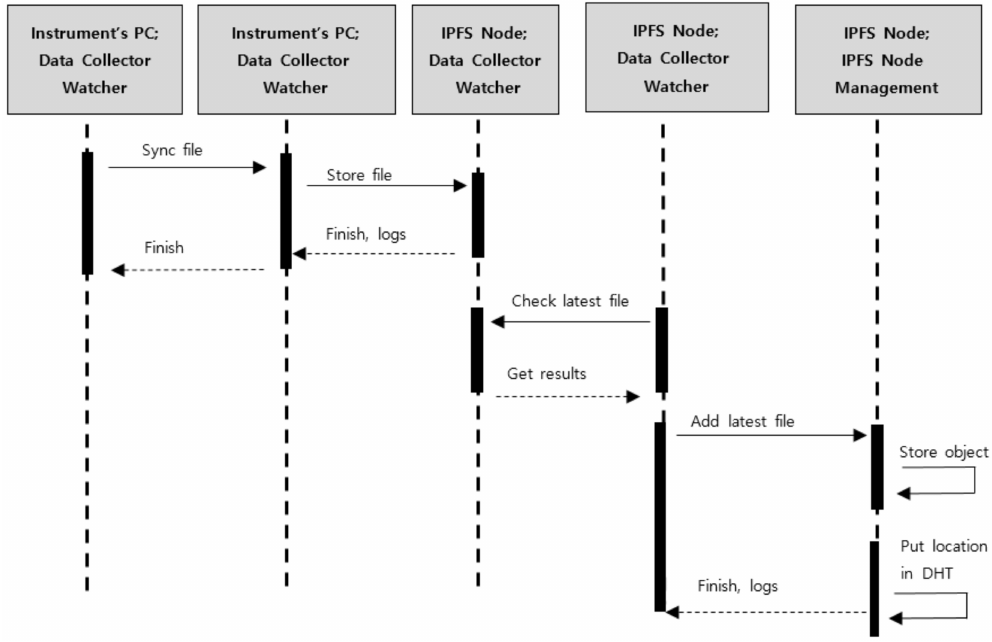
Figure 6. The Sequence of how the file was